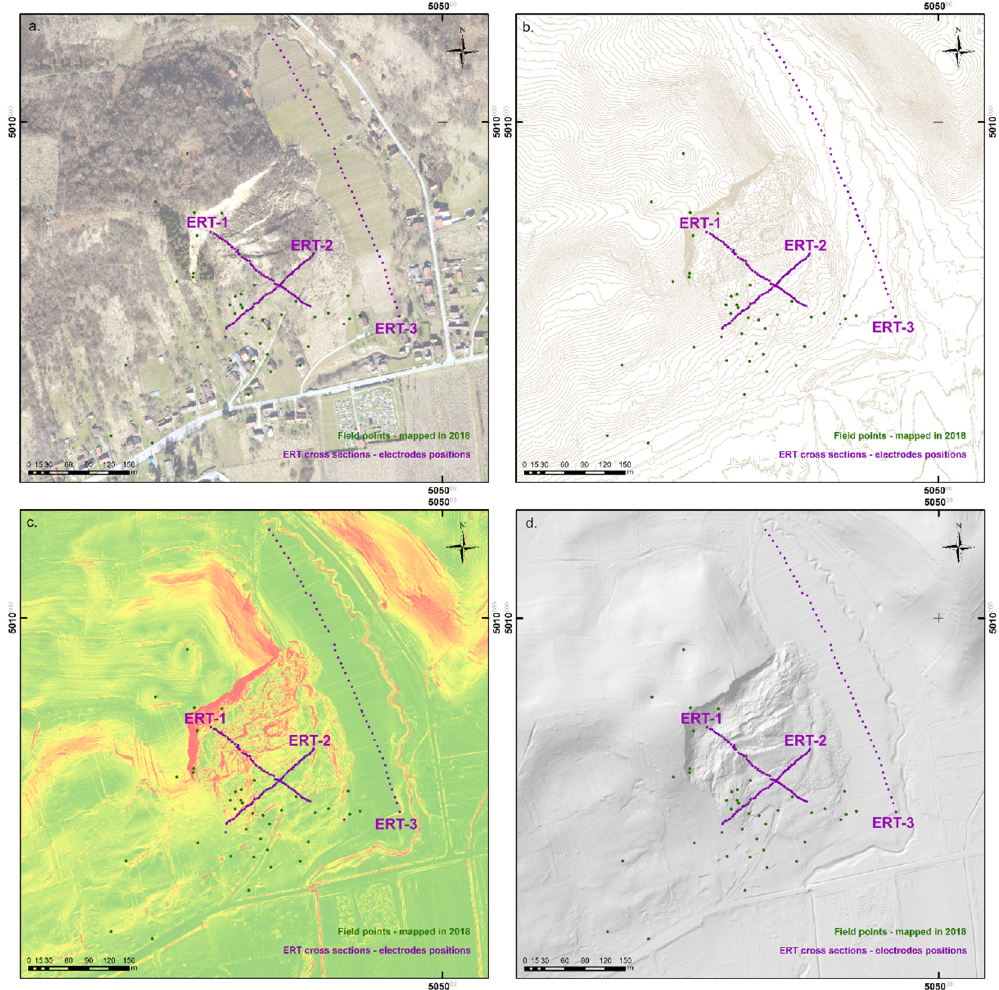
Figure 7. High resolution data from the Hrvatska Kostajnica area and landslide study area with mapped field points from 2018 and locations of ERT cross sections from 2020 and 2021: ( a ) detailed orthohpto from 2021; ( b ) 1 m contour lines based topography map; ( c ) detailed slope model; and ( d ) detailed terrain hillshade model.